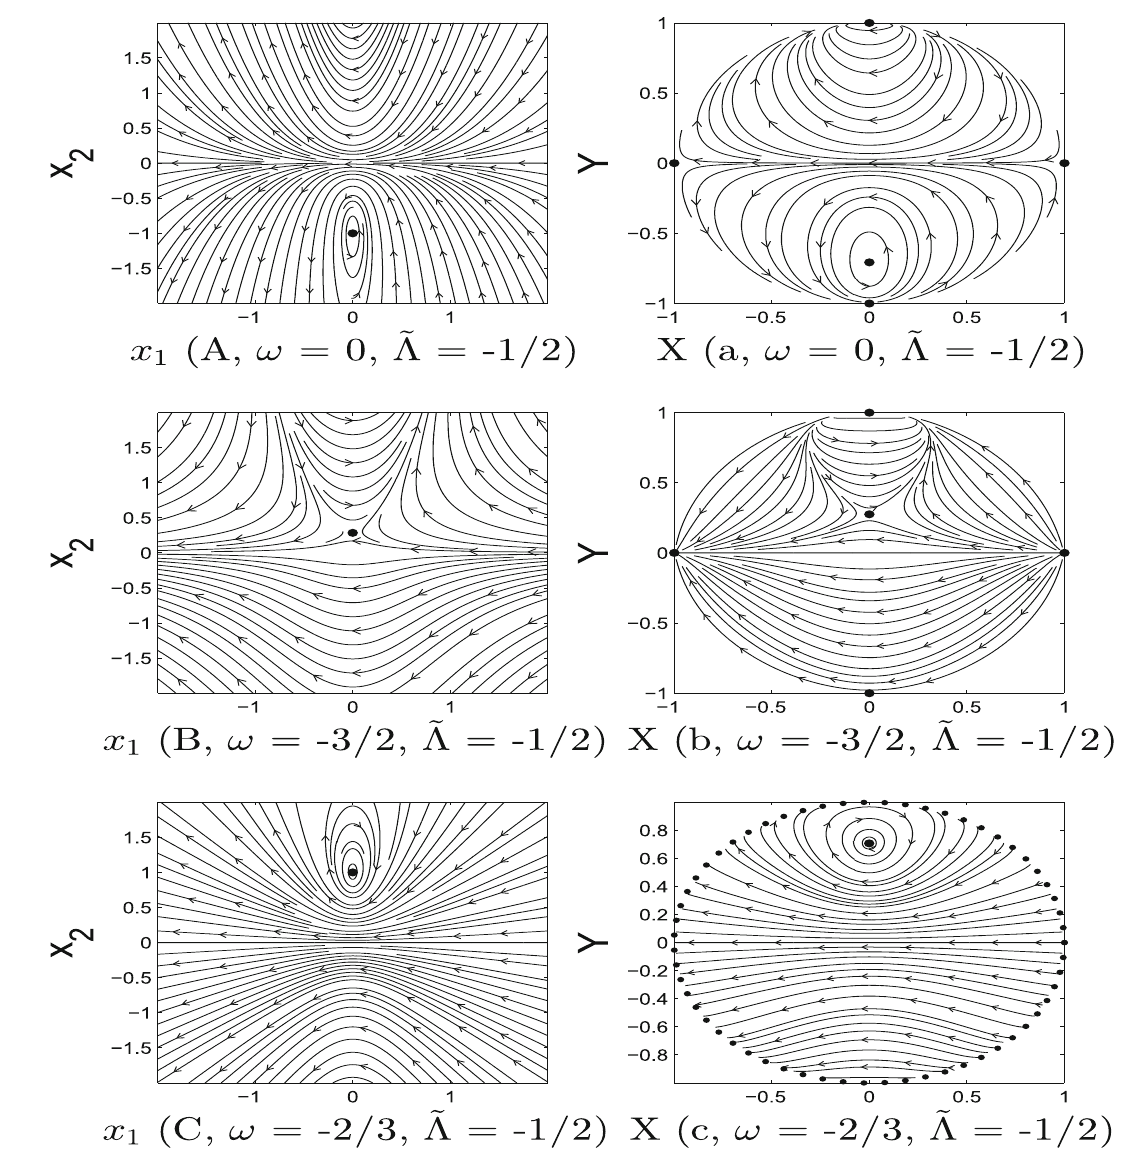
Fig. 9 Uncompact (left panel) and compact (right panel) phase por- traits when cosmological constant is included. Representative cases are (cid:11) ω = 0 , ˜ (cid:4) = − 1